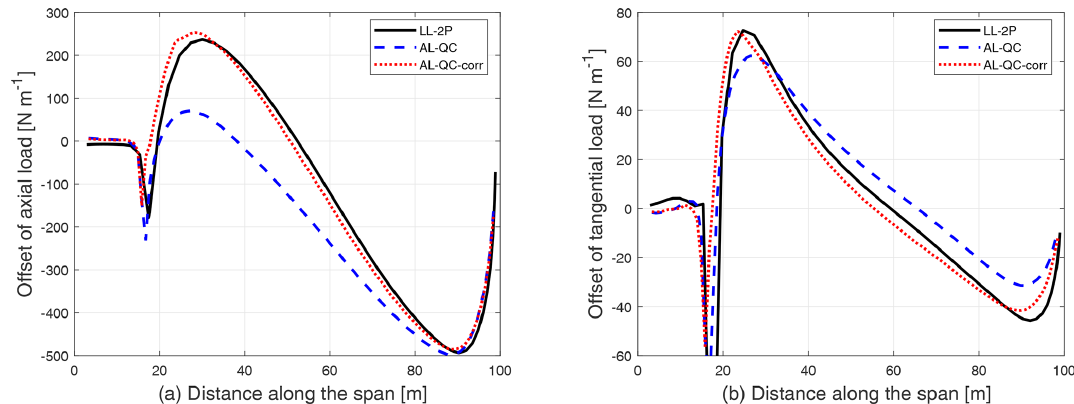
Figure 18. Comparison of the difference in axial load (a) and tangential load (b) of the straight blade with 15 ◦ of downwind coning compared to the straight blade without coning calculated from LL-2P, AL without the one-point correction (AL-QC) and AL with the one-point correction